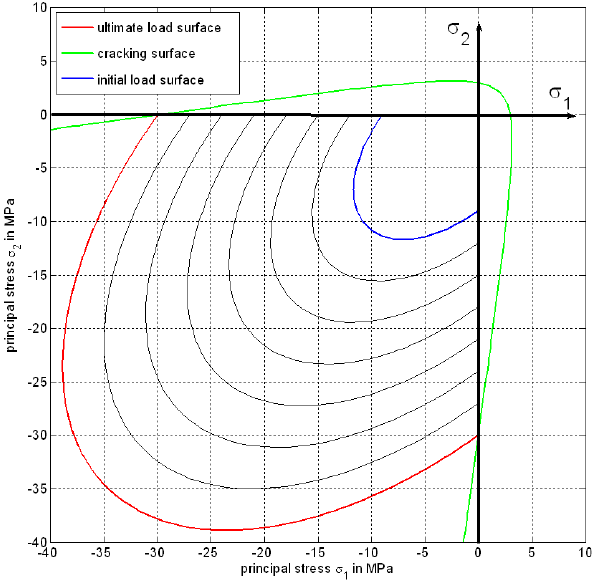
Fig. 6. Crack surface (tensile regime) and yield surfaces (compres- sive regime) depicted in principal stress